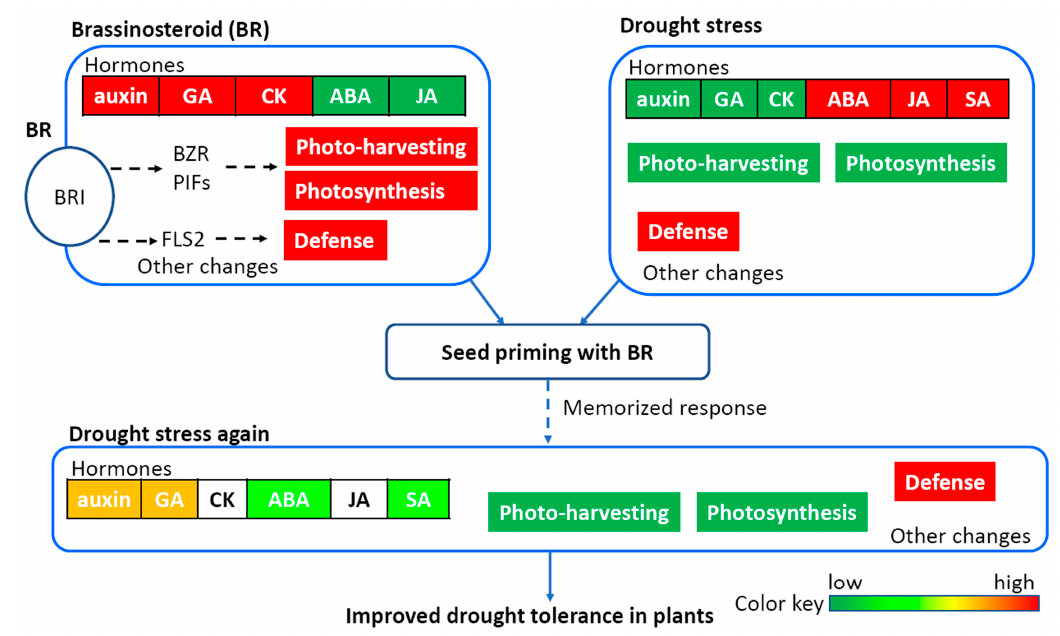
Figure 9. The proposed mechanism of BR priming inducing drought tolerance. The diagram shows the BR priming increases plant growth, photosynthesis, and defense via gene regulation, and the response could be memorized. Once the drought stress occurs, the memorized regulation could be recalled in a fast-adaptive way, which rescues the adverse e ff ects of drought stress. Finally, the seed priming with BR results in an improved drought tolerance in peanut plants. BRI: BRASSINOSTEROID INSENSITIVE1; BZR, BRASSINAZOLE RESISTANT1; PIFs: PHYTOCHROME INTERACTING FACTORS; FLS2: